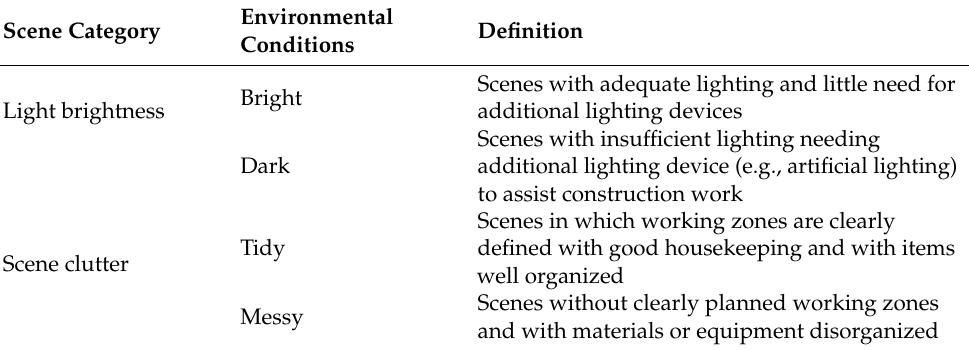
Table 2. Site scene selection and descriptions of each